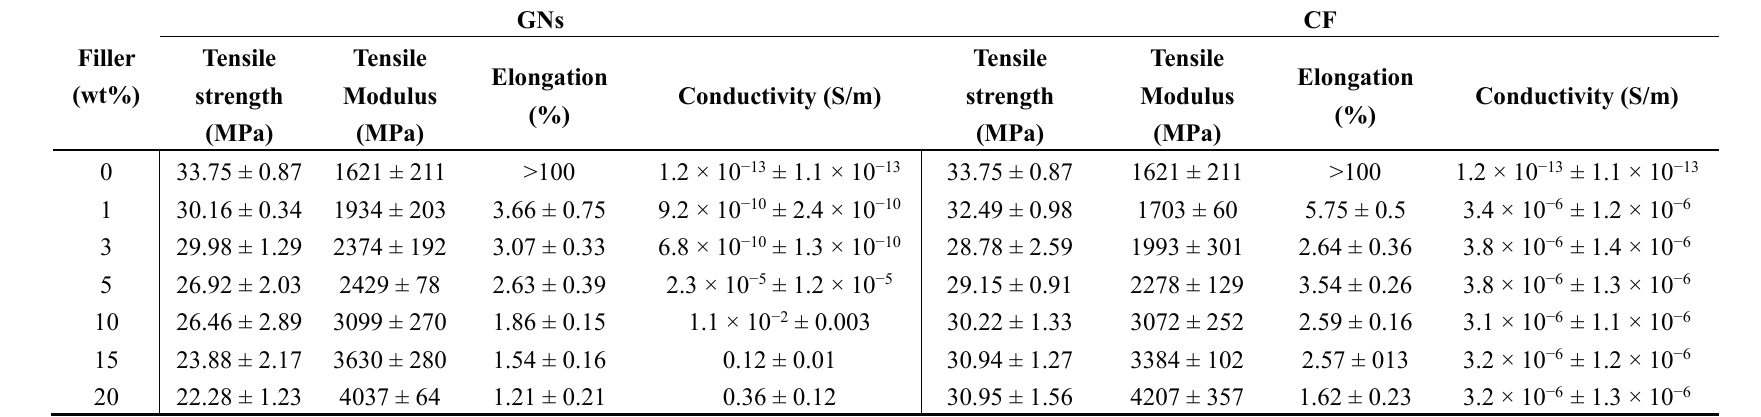
Table 3. Tensile properties and electrical conductivity of PP/GNs and PP/CF